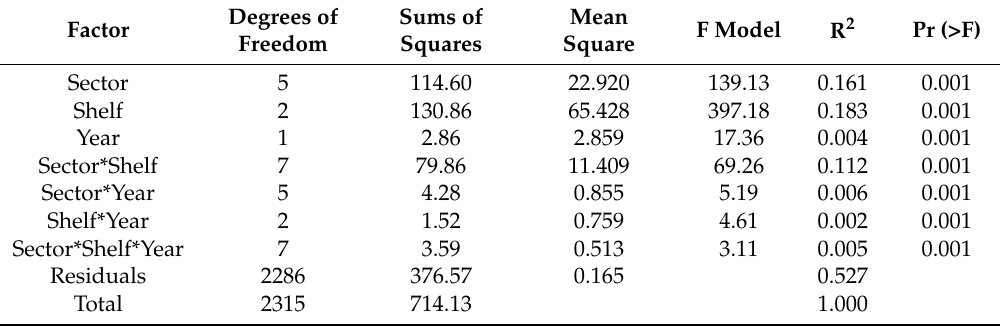
Table 2. Results of a permutational multivariate analysis of variance (ADONIS) testing for differences in the structure of planktivorous damselfish assemblages on the Great Barrier